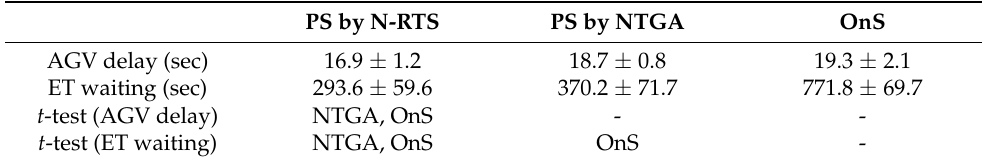
Table 4. Results obtained by averaging the performances measured on ten test scenarios (significance level: 0.95).